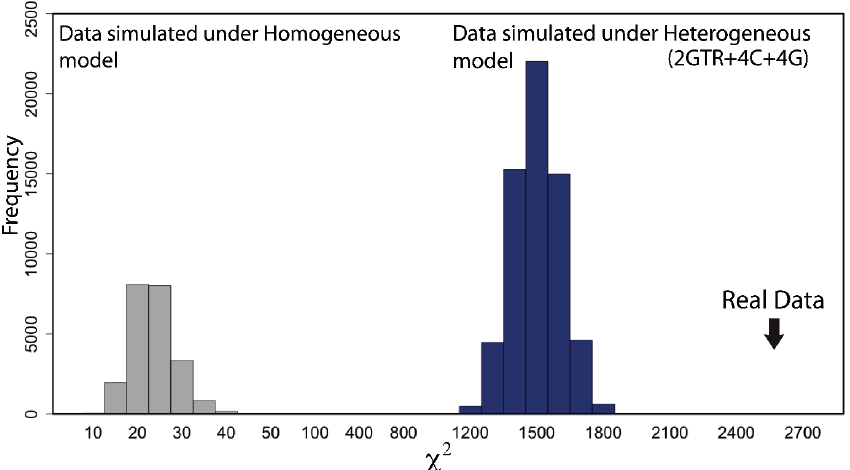
Figure 3. Assessment of fit of the Homogeneous and Heterogeneous models for the RomiguierTopAT dataset. The leftmost histogram in grey shows the results of the posterior predictive simulation for RomiguierTopAT using the homogeneous model. The rightmost histogram in blue shows the improved posterior predictive simulation on modeling RomiguierTopAT with the heterogeneous model of best fit ( i.e. , 2GTR + 4C + 4G for RomiguierTopAT). In both simulations the X -axis represents the parameter of comparison taken from the simulations, and the Y -axis represents the frequency. The large black arrow indicates the value of test statistic ( χ 2 ) retrieved from the real